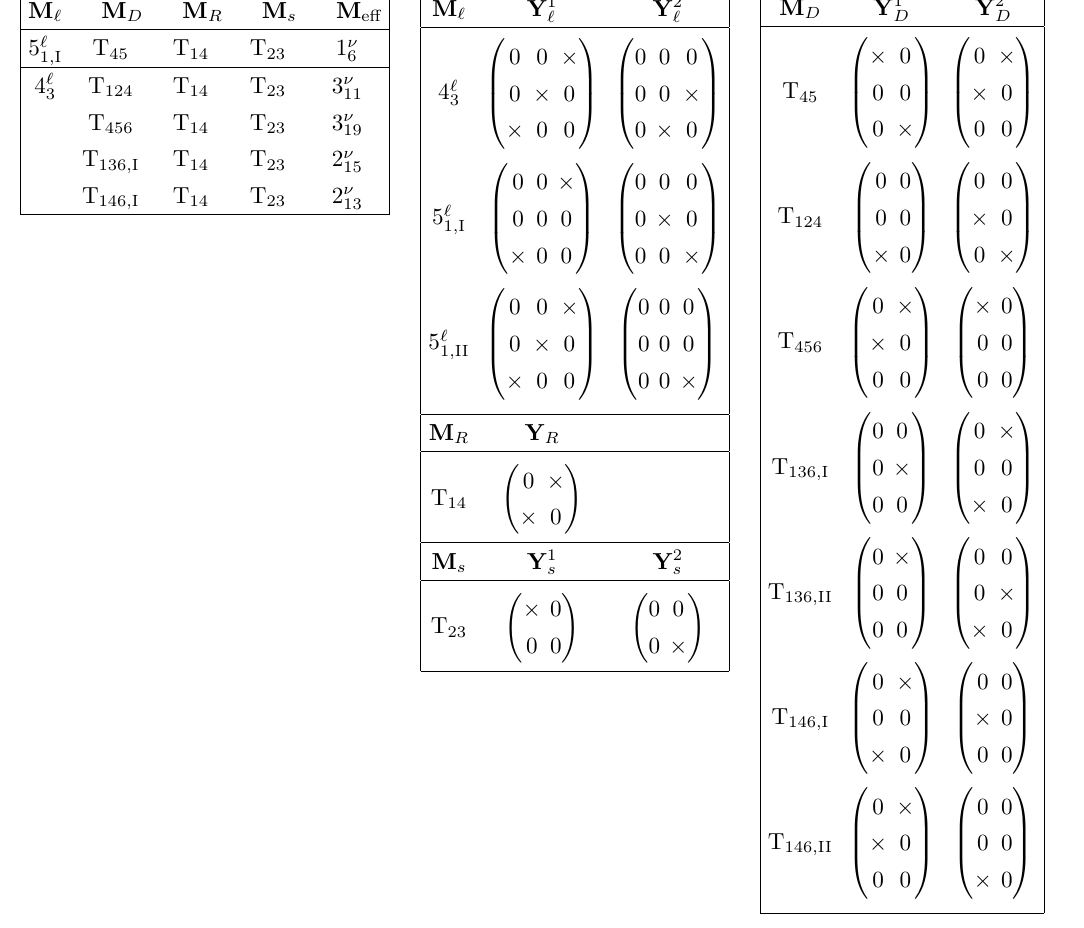
Table 5 . (Left) Maximally-restrictive texture-zero sets compatible with neutrino oscillation data and realisable through Abelian symmetries. (Centre and right) Decomposition of mass matrices into the Yukawa textures according to eq.